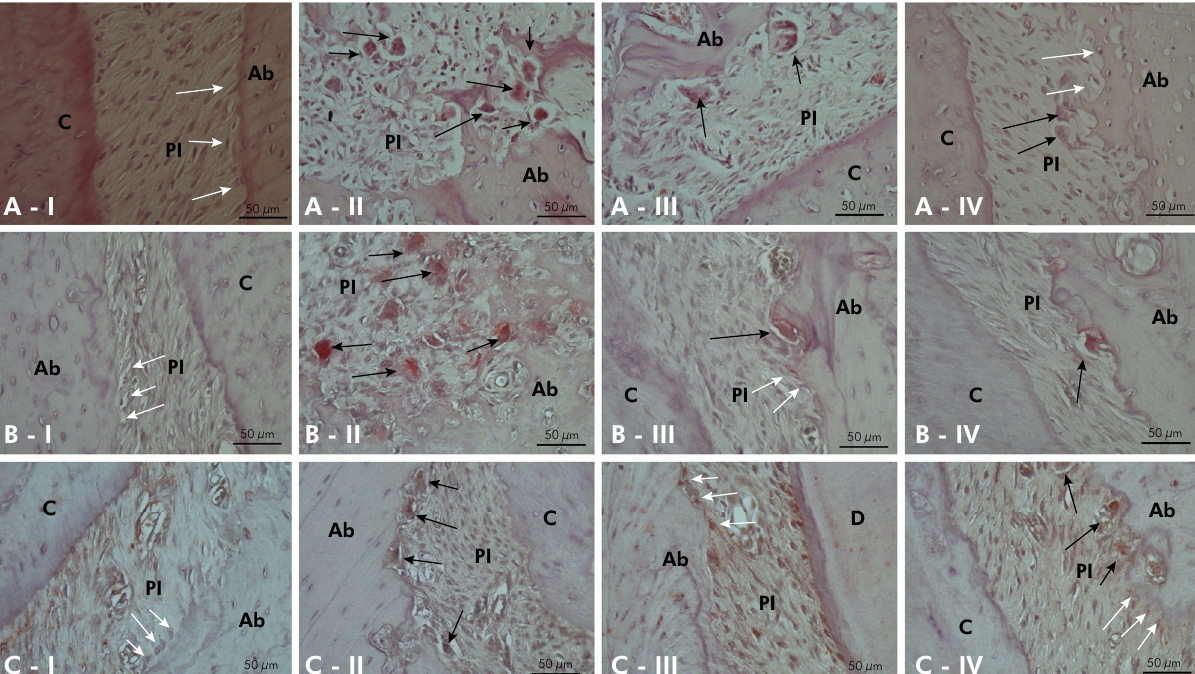
Figure 3. Representative samples of TRAP, hematoxylin and MMP-1-stained periodontium from Wistar rats. A: TRAP staining